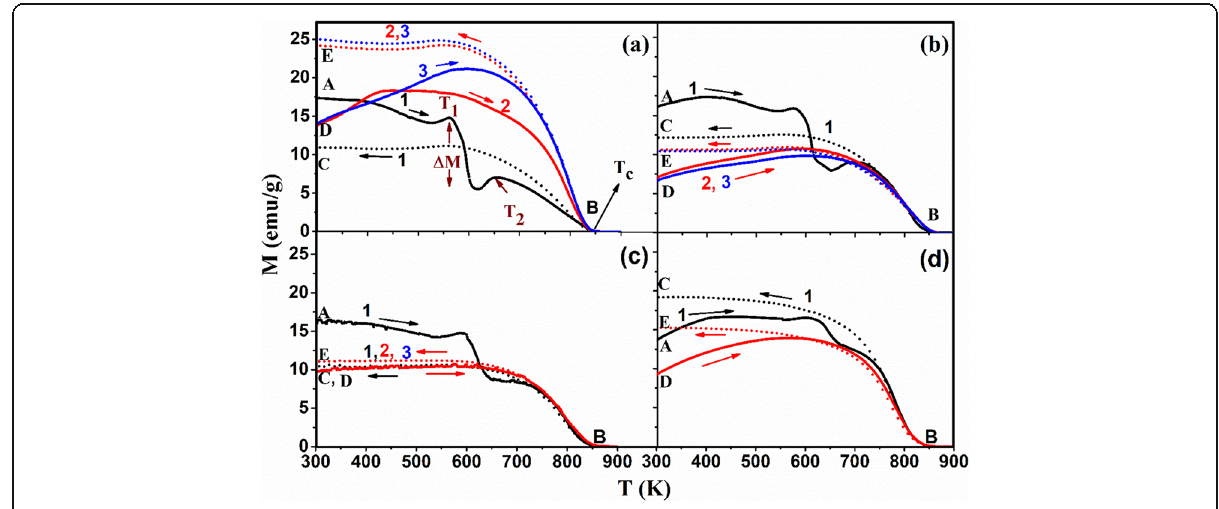
Fig. 1 Change of magnetization (M) with temperature of pristine and Sn x Fe 3-2/3 x O 4 nanoparticles of Sn 2+ ( x ) amount a 0.000 (pristine Fe 3 O 4 ), b 0.045, c 0.090, and d 0.150 respectively, for different heating – cooling cycles [for a and b , black indicates 1st; red, 2nd; blue, 3rd and for c and d , only 2-cycles are indicated] (magnetic field H = 200 Oe) (solid line, heating; dotted line,